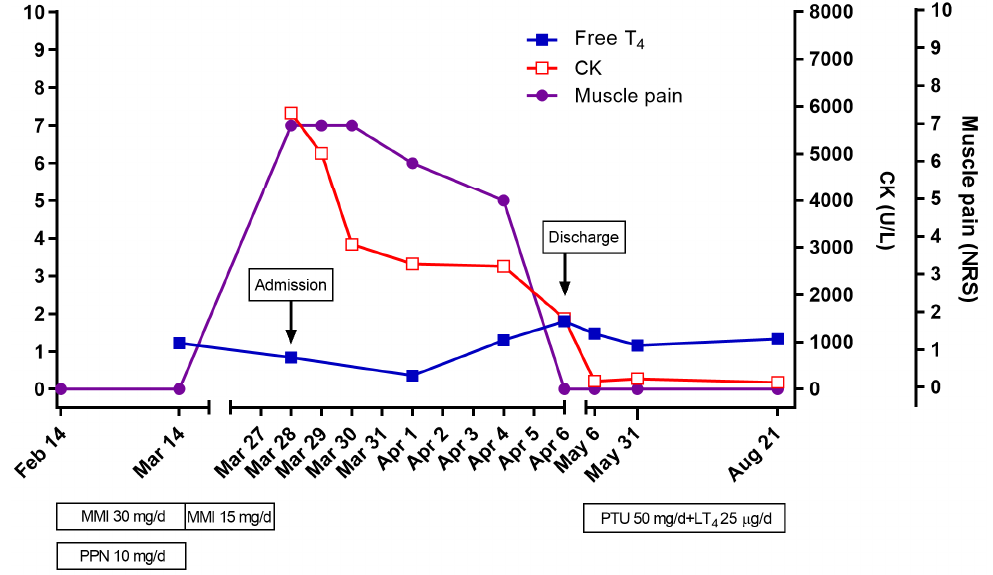
Figure 1. The clinical course of myopathy associated with treatment of Graves’ disease. CK, creatine kinase; LT 4 , levothy- roxine; MMI, methimazole; NRS, numerical rating scale.